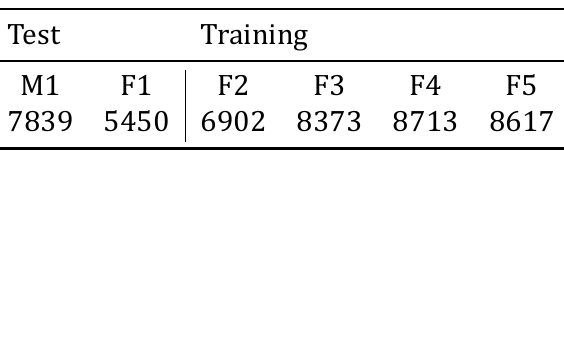
Table 1: Average spectral center of gravity (Hz) for the maximally-ambiguous fricative for each training and test